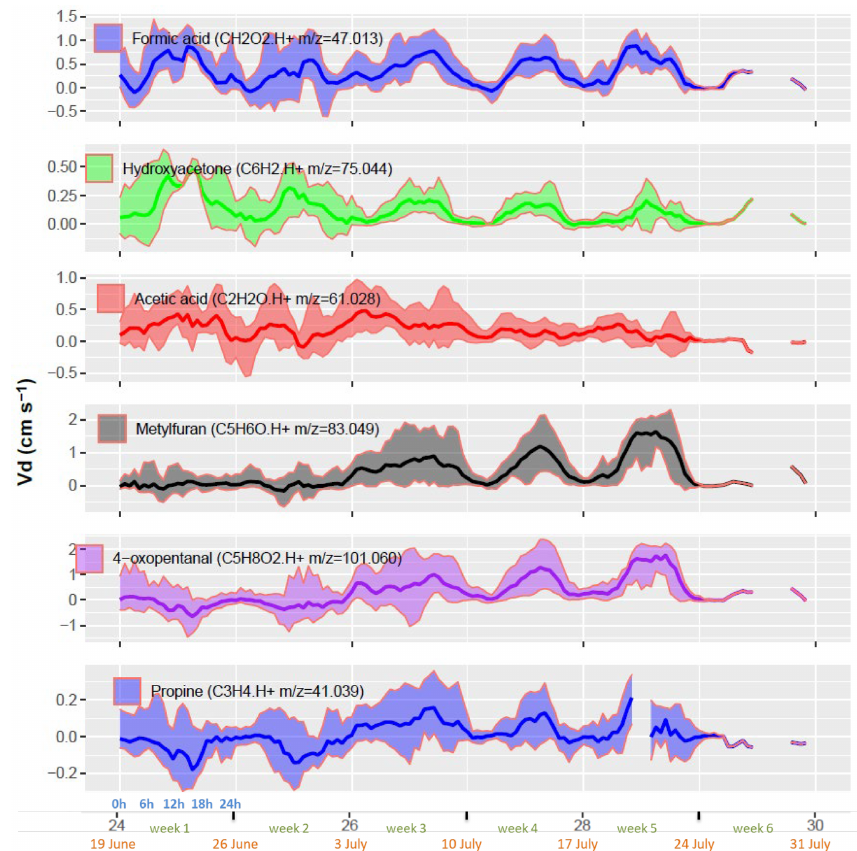
Figure 8. Diurnal cycle of deposition velocity of the six most deposited VOCs. Each week shows the diel cycle with its mean (line) and standard deviation (ribbons). The x axis shows the week number in the year (black), the week number in the experiment (green), the starting date of the week (orange) and the hour of day (blue). Only 1d of measurements was available during week 6, leading to no interquartile computation and hence no ribbons.